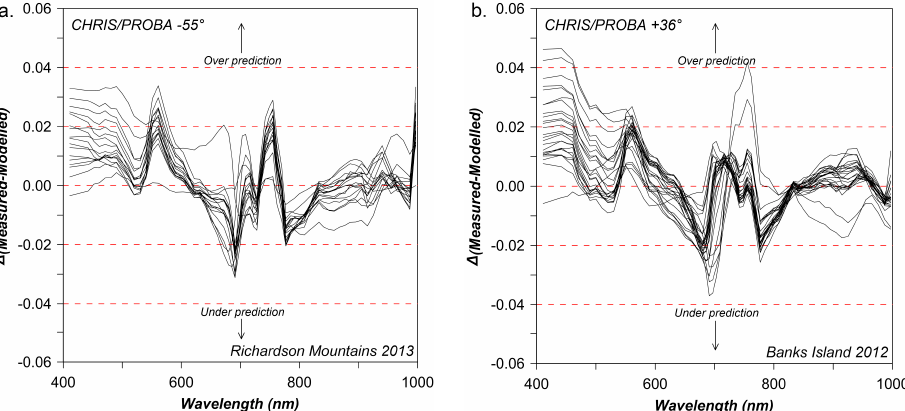
Figure 8. Examples representing the range of measured and modelled top-of-canopy (TOC) spectral-directional reflectance curves for: ( a ) Richardson Mountains (2013) with more dense vegetation cover (view zenith angle, VZA = − 55°); and ( b ) Banks Island with sparse vegetation cover (VZA = +36°).